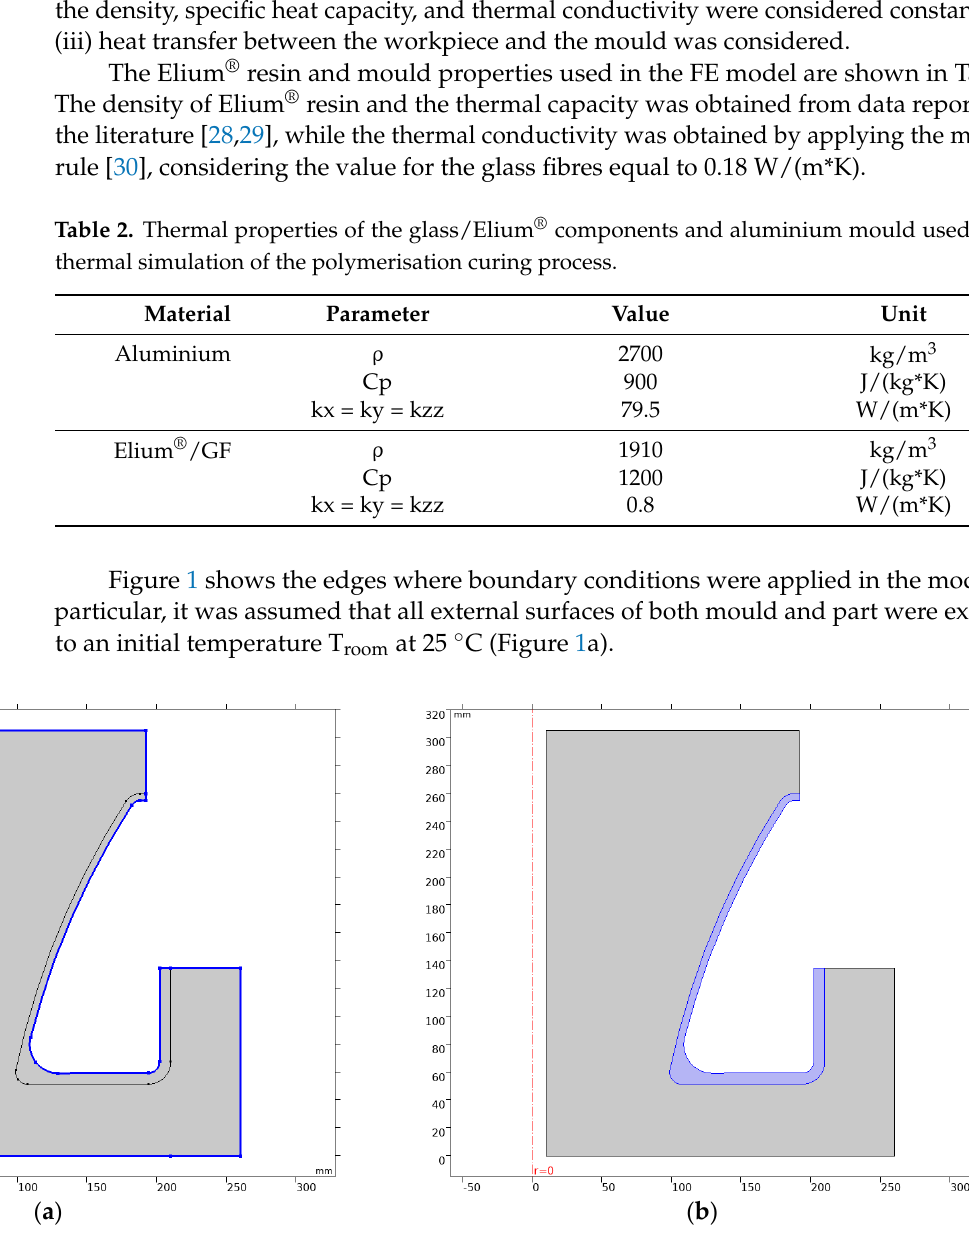
Table 2. Thermal properties of the glass/Elium ® components and aluminium mould used in the thermal simulation of the polymerisation curing process.